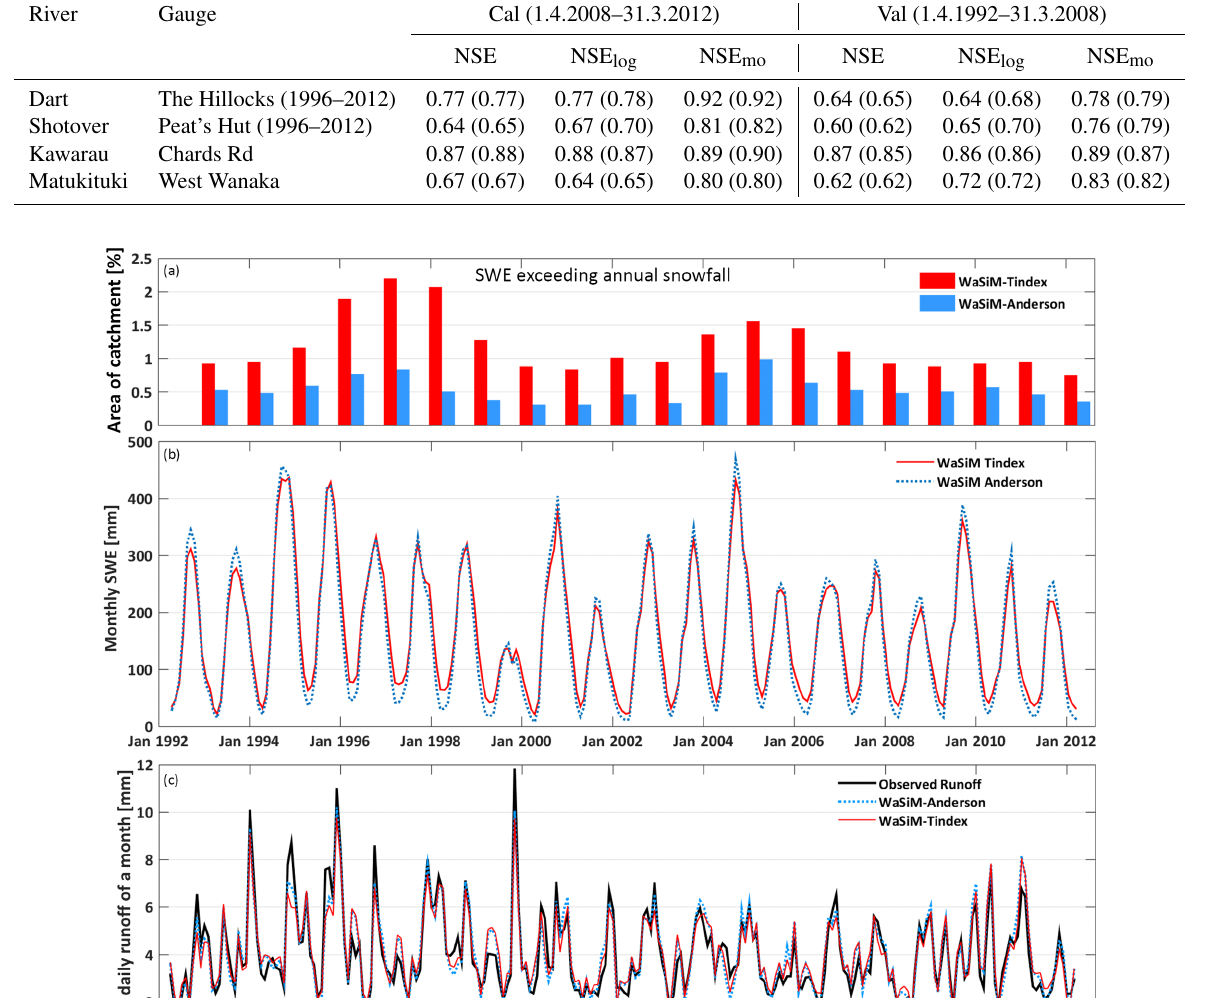
Table 2. Nash–Sutcliffe values based on daily (NSE), logarithmic (NSE log ) and monthly (NSE mo ) streamflow data during the calibra- tion (Cal) and validation (Val) periods, calculated for the WaSiM-Anderson and WaSiM-Tindex (in brackets) simulations. Note the different validation periods for The Hillocks and Peat’s Hut due to shorter records.